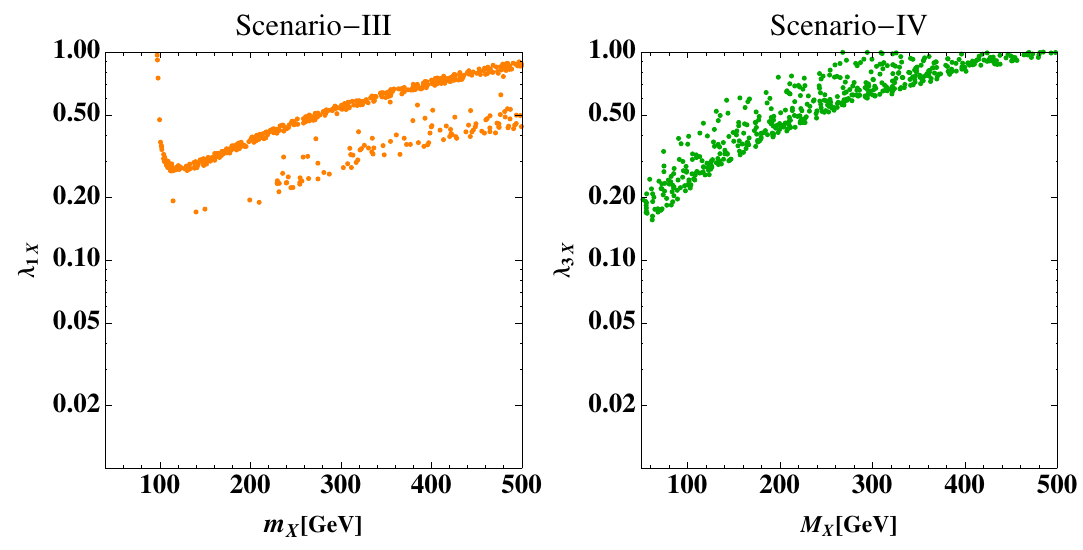
Figure 4 . Left: scatter plot for parameters on m X - (cid:21) 1 X plane under the DM relic abundance bound in Scenario-III. Right: that for parameters on m X - (cid:21) 12 X in